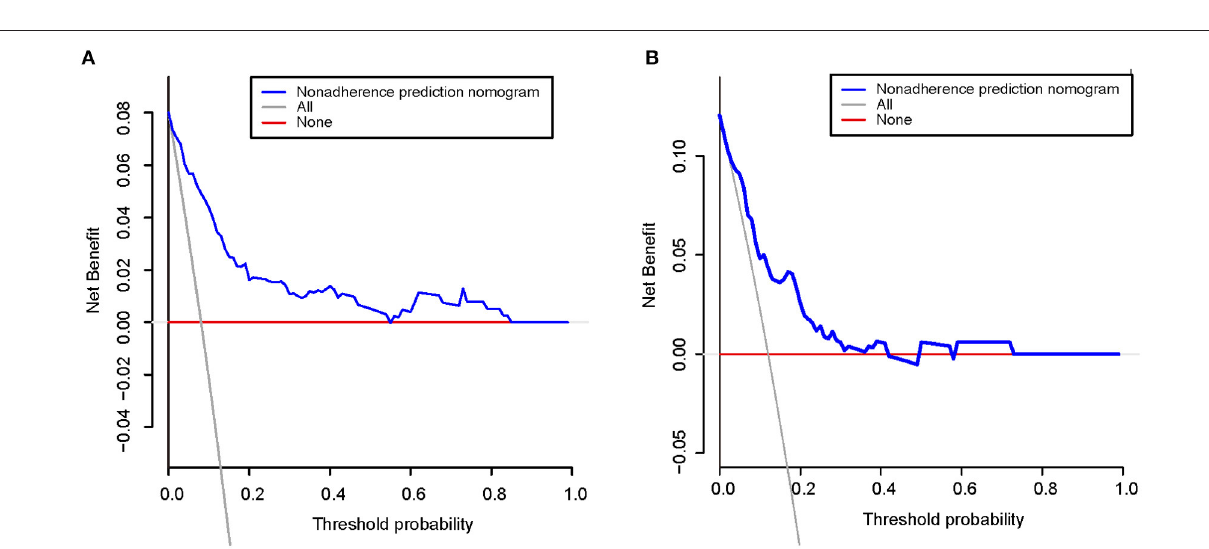
FIGURE 6 | Decision curve analysis for the training set (A) and the testing set (B) . A horizontal line indicates that all samples are negative and not treated, with a net benefit of zero. An oblique line indicates that all samples are positive. The net benefit is a backslash with a negative